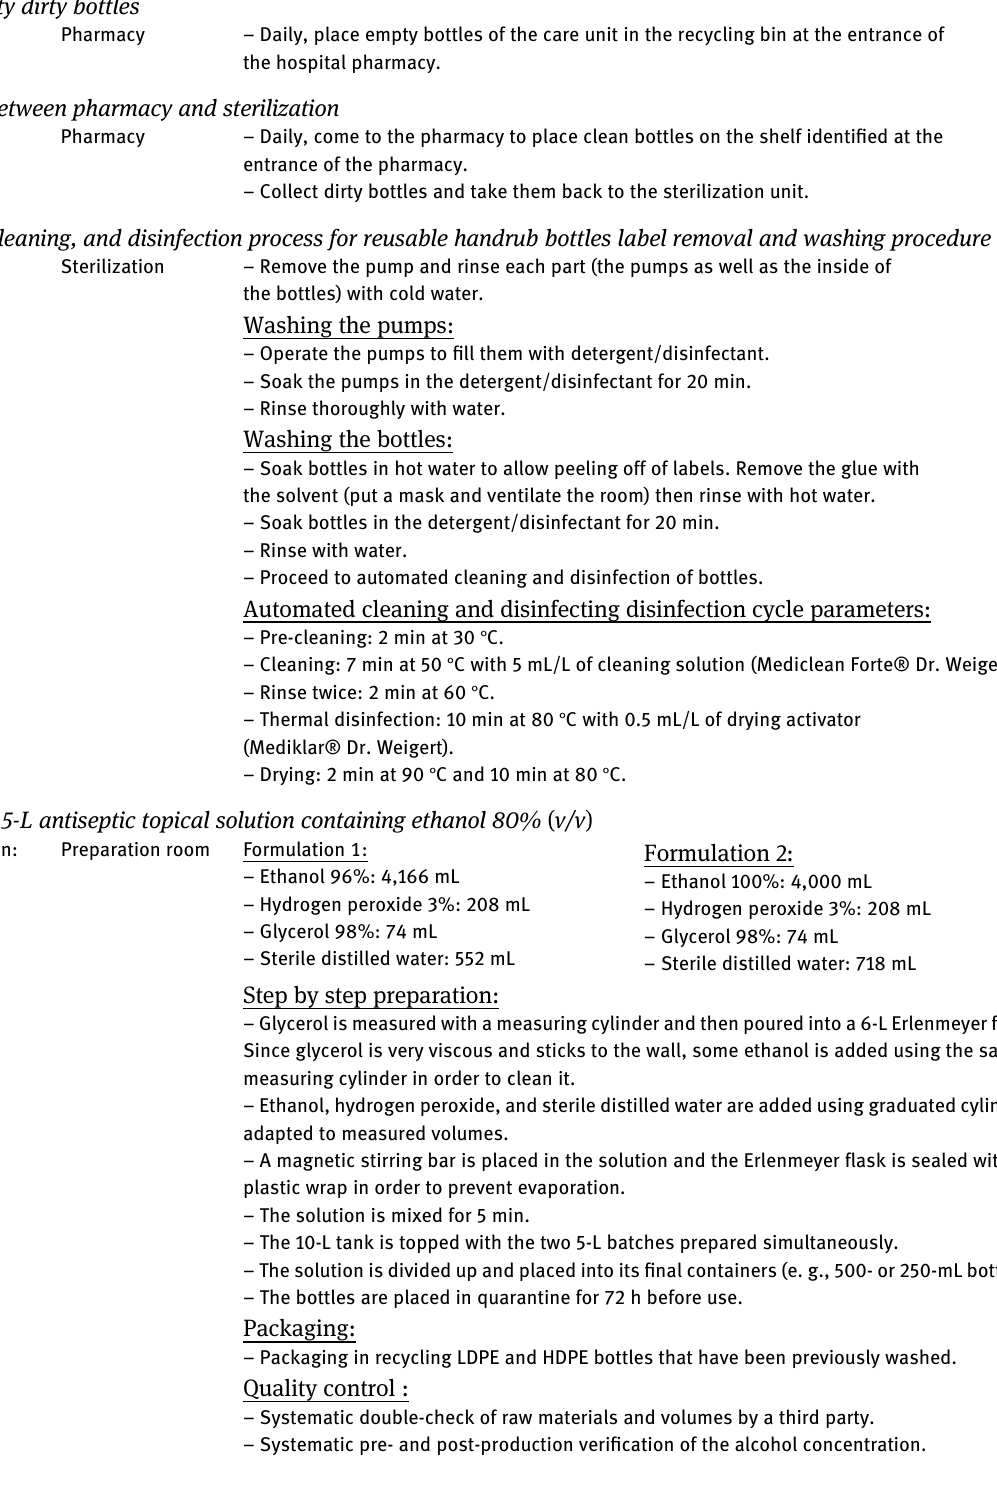
Table  : Procedure for alcohol-based handrub production.